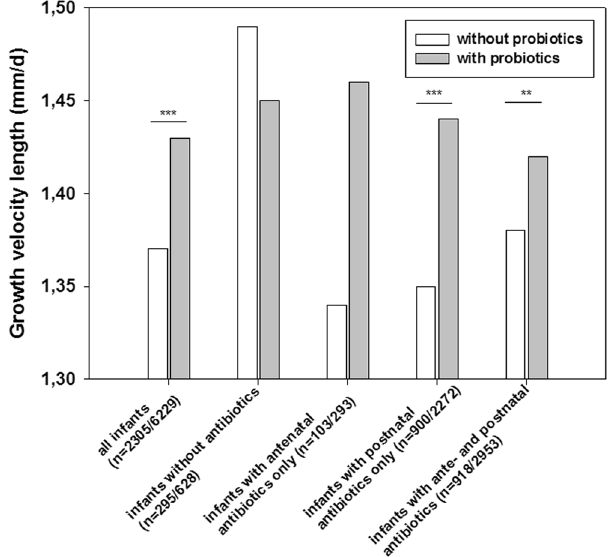
Figure 3. The effect of probiotics and modification by antibiotics on body length. The figure describes the effect of probiotics on growth velocity [difference of birth and discharge measures/number of days (duration of primary stay in hospital)] for body length. The effect is modified by exposure to antibiotics, the different strata are depicted on the x-axis. For each stratum, numbers of infants without probiotic treatment/with probiotic treatment are given. * p < 0.05, ** p < 0.01, *** p < 0.001 (Fisher’s exact test, two-sided).